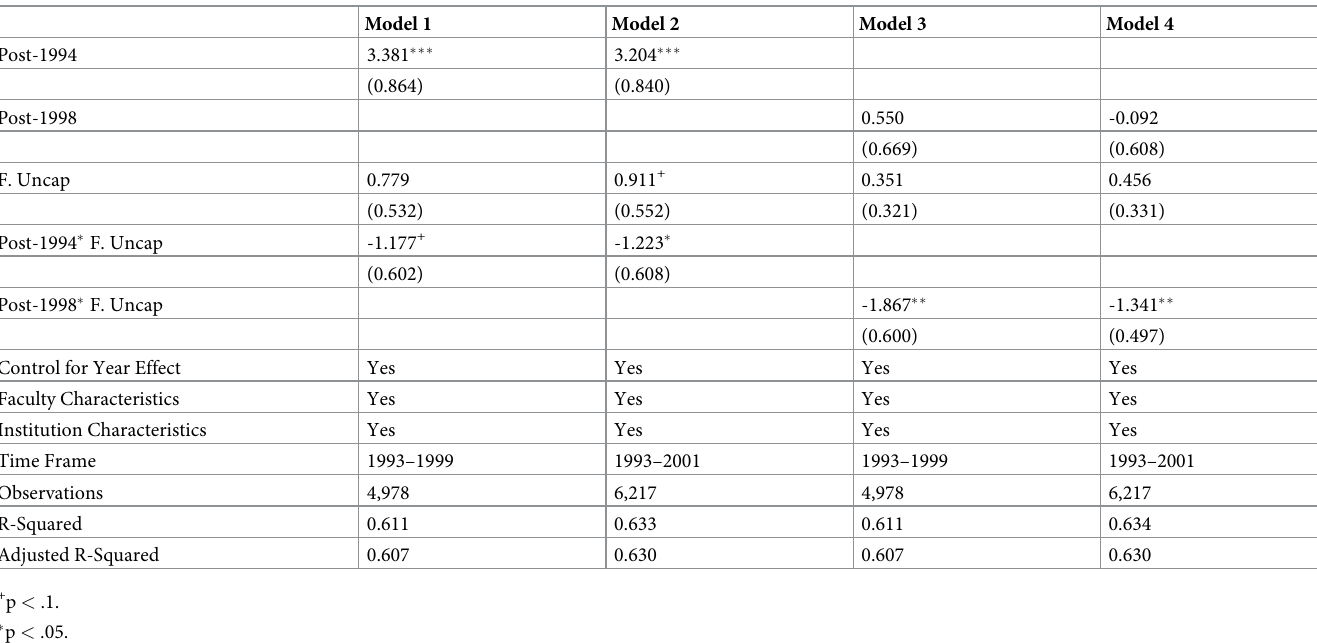
Table 4. Regression results for the impact of elimination of the mandatory retirement policy on the number of new